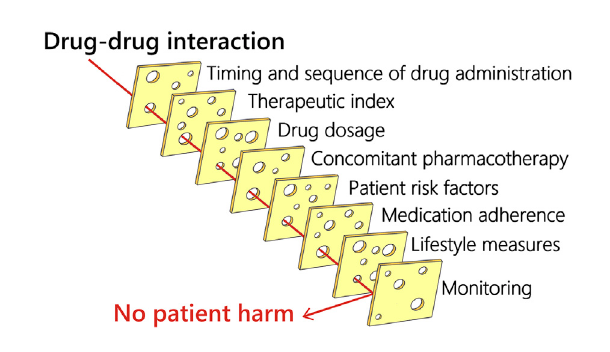
FIGURE 2 Factors that might in fl uence whether potential DDI will lead to patient